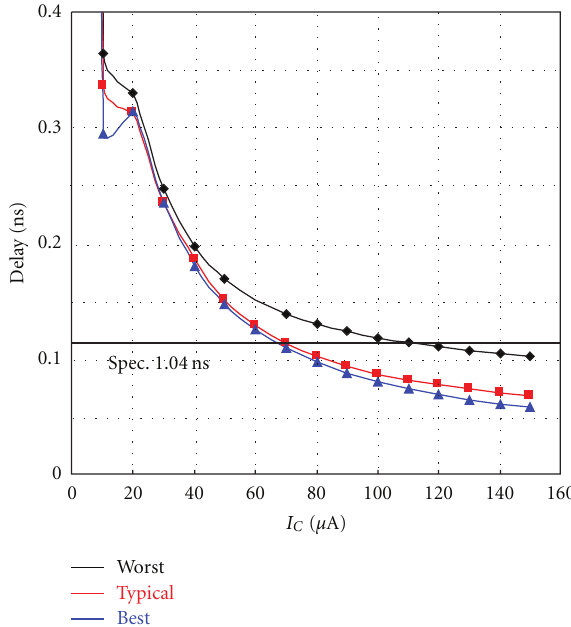
Figure 18: Postlayout simulation results of VCDL delay-current characteristics for